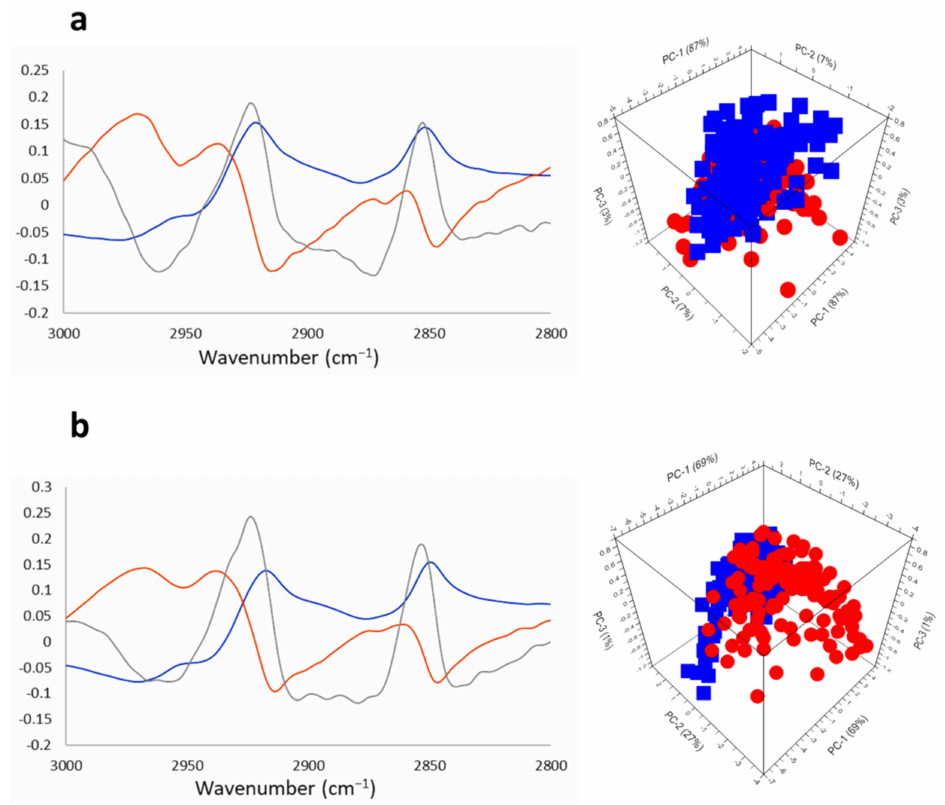
Figure 10. PCA and loadings within the lipid region (3000–2800 cm − 1 ) of GICs samples treated with Na[ o -COSAN] 200 µ M: ( a ) GIC7 and ( b ) PG88 cells. Principal component loadings (blue PC-1, orange PC-2, grey PC-3) are shown on left panels. Right-panels show principal component analysis score plots of PC-1, PC-2, and PC-3 displaying the variance between GIC control cells (blue) and GIC treated cells